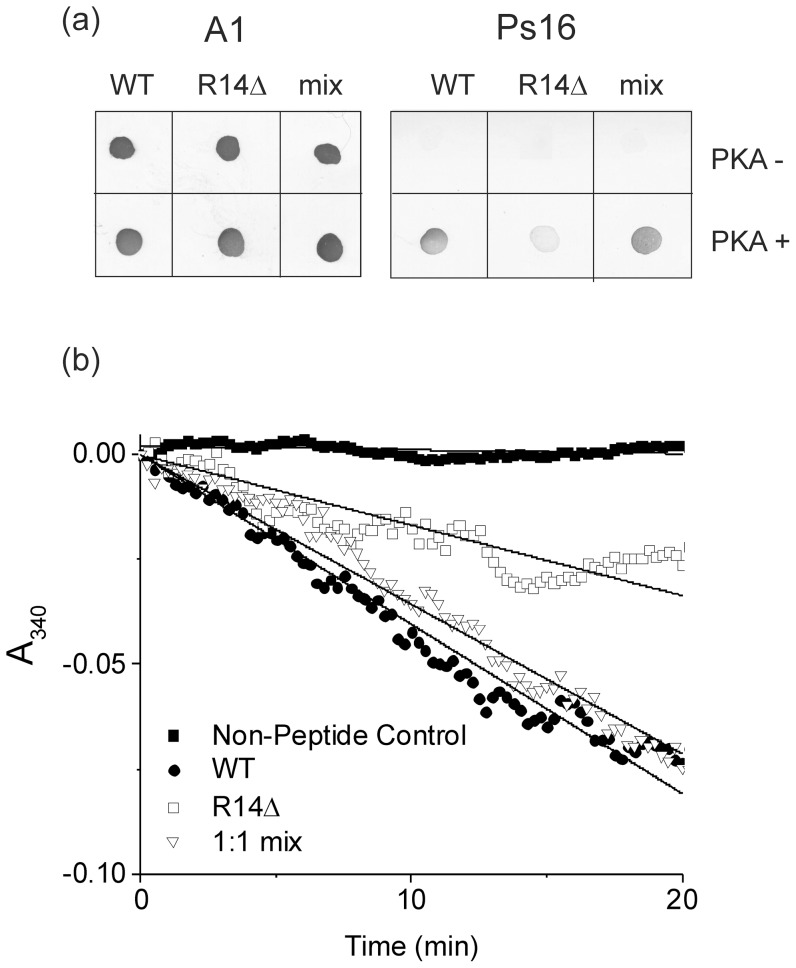
PKA-catalysed phosphorylation of PLBWT and PLBR14Δ: Relative ability of PKA to phosphorylate PLBWT, PLBR14Δ and an equimolar mix of PLB conformers was measured by a) dot blot analysis using PLB Ab A1 to detect both phosphorylated and unphosphorylated protein and Ab PS16 to detect phosphorylated forms of PLB only; b) real time measurement of ADP production resulting from successful PKA phosphorylation. Data (n = 3) were measured in triplicate in a single 96 well plate experiment and for clarity only the mean values are shown.